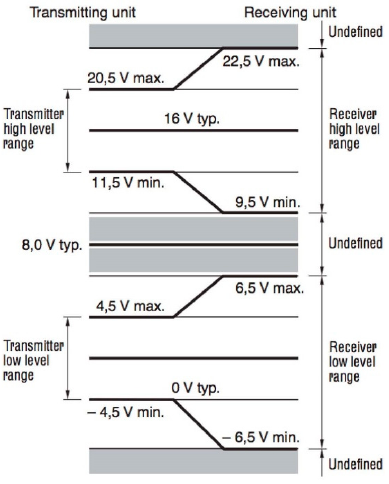
Figure 12. DALI logic levels.